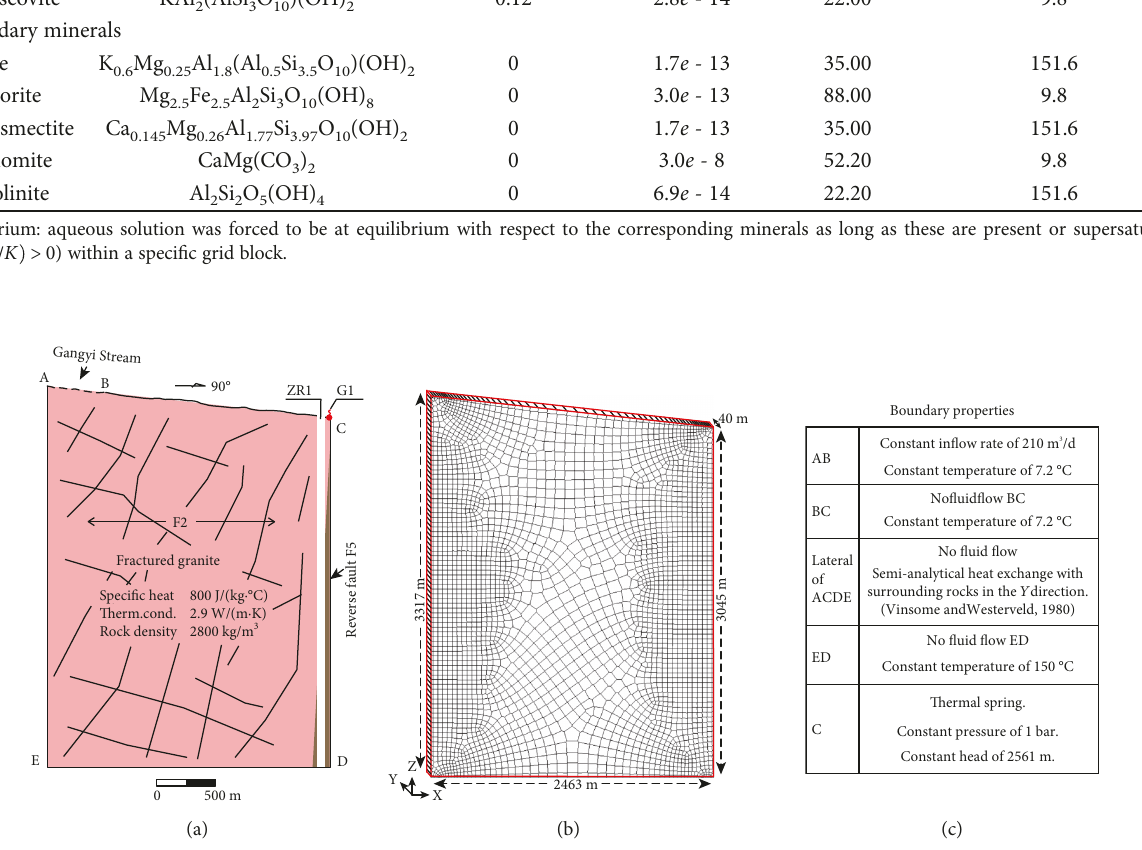
Figure 3: (a) Model domain of the conductive fault F2 and physical parameters, where land surface elevation extracted from digital elevation model, and the depth of F2 from the electromagnetic and gravity prospecting [19]; (b) irregular mesh generated by Gambit software (Fluent Inc.) with mesh re fi nement in the recharge and discharge zones; (c) boundary conditions for fl ow and heat in the fault F2 in the numerical